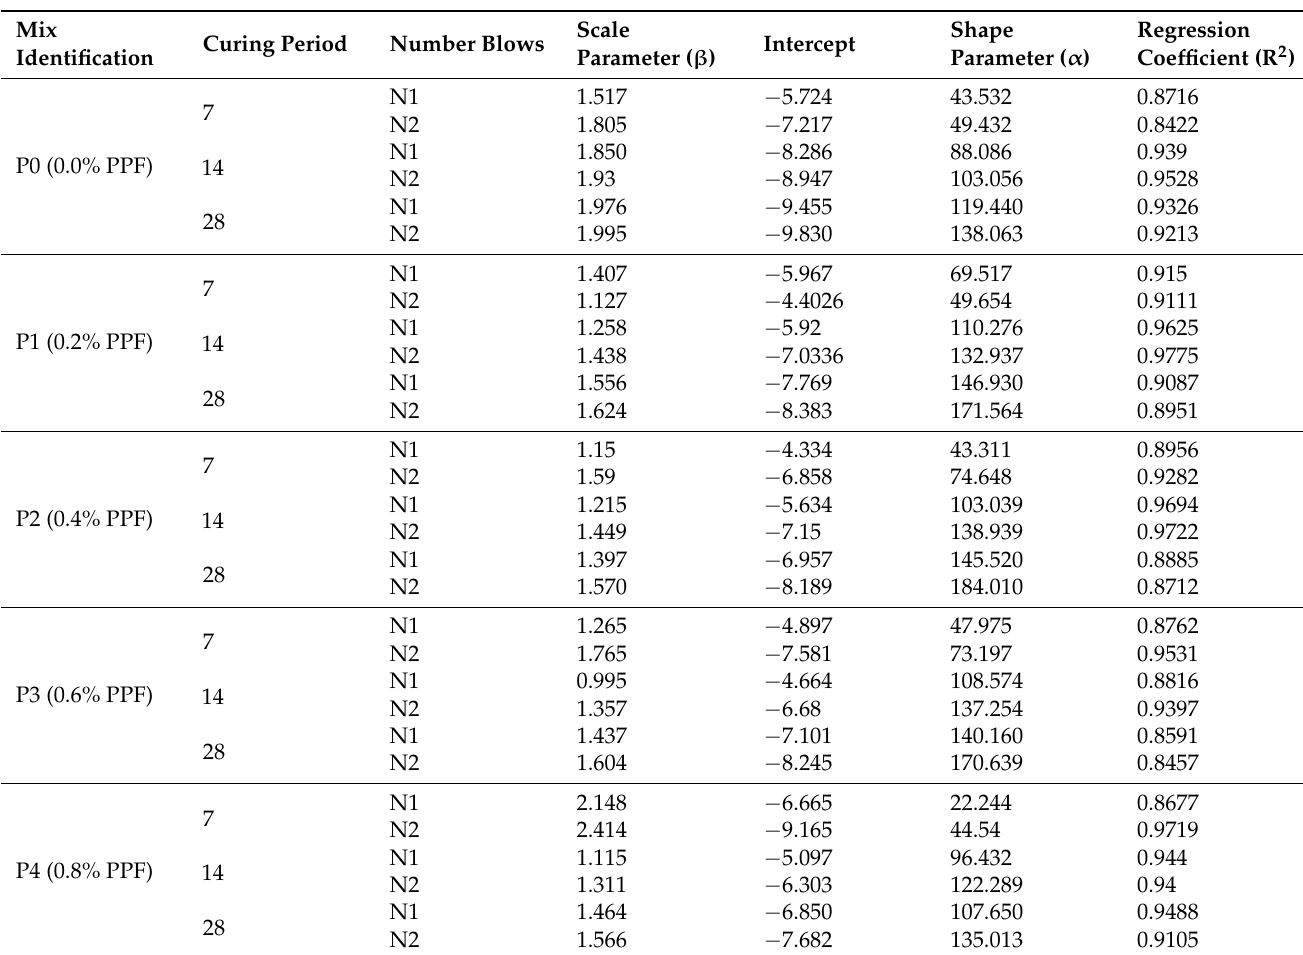
Table 6. Weibull distribution parameters and regression